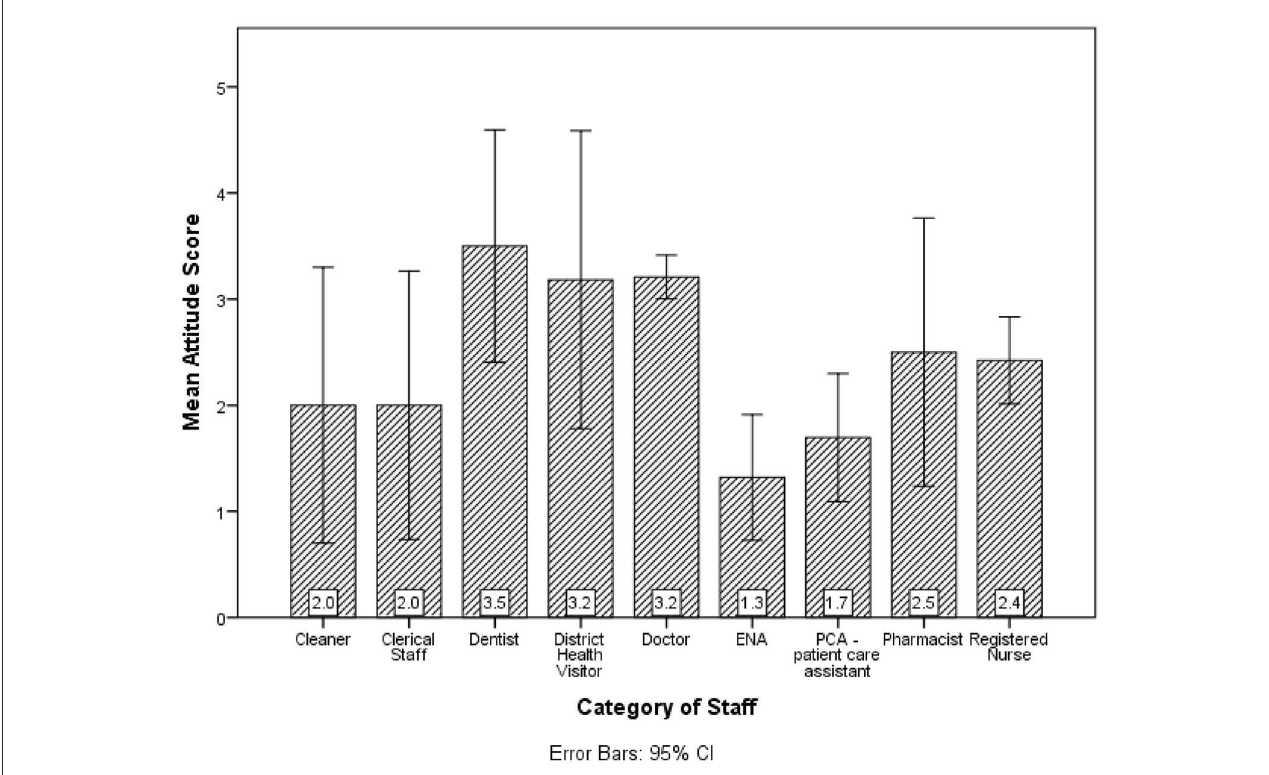
FIGURE3 Participants’ mean attitude score toward the AstraZeneca vaccine by category of